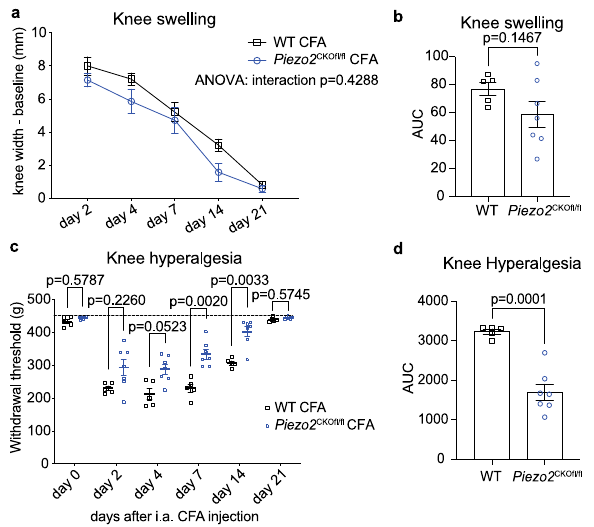
Fig. 3 | Piezo2 depletion protects from CFA induced mechanical sensitization. a Knee swelling was assessed in female wild-type (WT) (black squares) or homo- zygous Piezo2 CKOfl/fl (blue circles) mice given a single intra-articular injection of Complete Freund ’ s adjuvant (CFA) (i.a. 5 µ g, 5 µ L). Two-way repeated measures ANOVA. b Area under the curve analysis over the time course was used to assess knee swelling. Unpaired two-tailed t -test. c Knee hyperalgesia was assessed in the same mice as part a . Dashed line indicates maximum of the assay: 450g. Two-way repeated measures ANOVA with Sidak ’ s post-test. d Area under the curve analysis over the time course was used to assess knee hyperalgesia. Unpaired two-tailed t -test. Mean±SEM. For a – d WT ( n =5) and homozygous female Piezo2 CKOfl/fl ( n =7) mice. i.a. CFA intra-articular Complete Freund ’ s adjuvant. For a – d , source data are provided as a Source Data fi